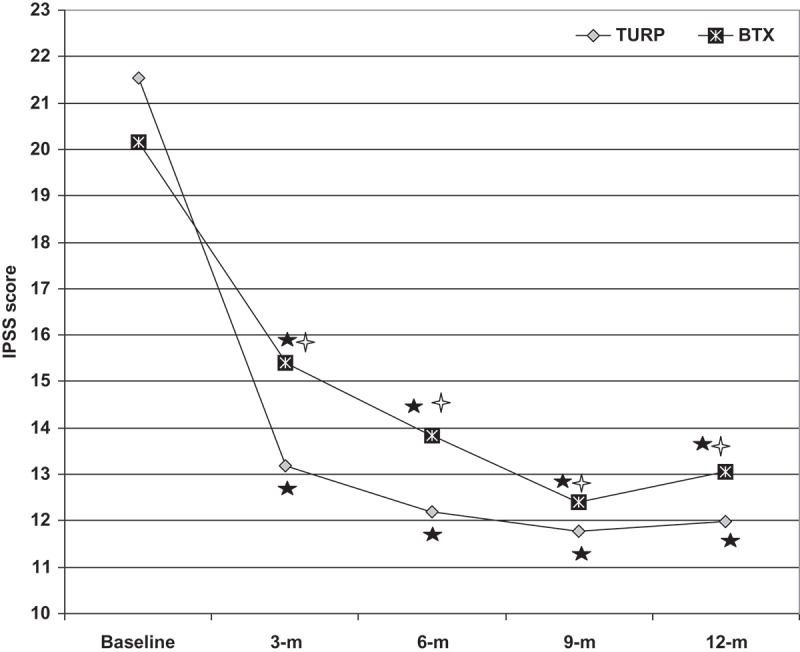
The mean IPSS of patients of both groups determined during follow-up compared to preoperative score (black star, indicates significant difference vs preoperative score); open cross, indicates significant difference vs score of TURP patients. m, months. BTX, BoNT-A.